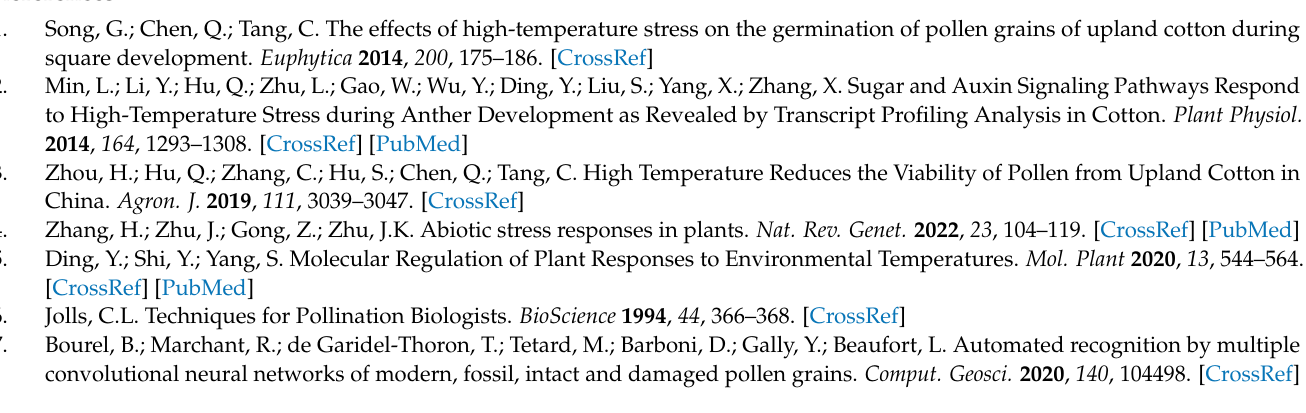
network. Figure S6: PollenDetect software interface. The software can select a single image or a group of images for pollen viability detection, and the test results will be counted and output to the text box for further statistics and